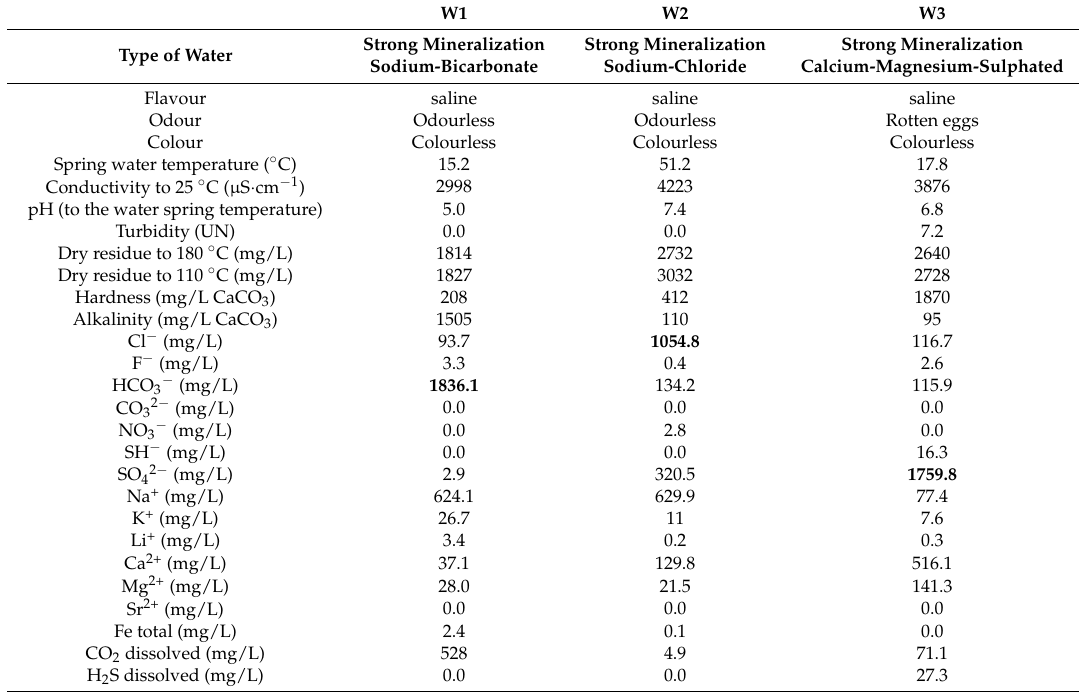
Table 3. The chemical composition and properties of the natural mineral waters used in this study.